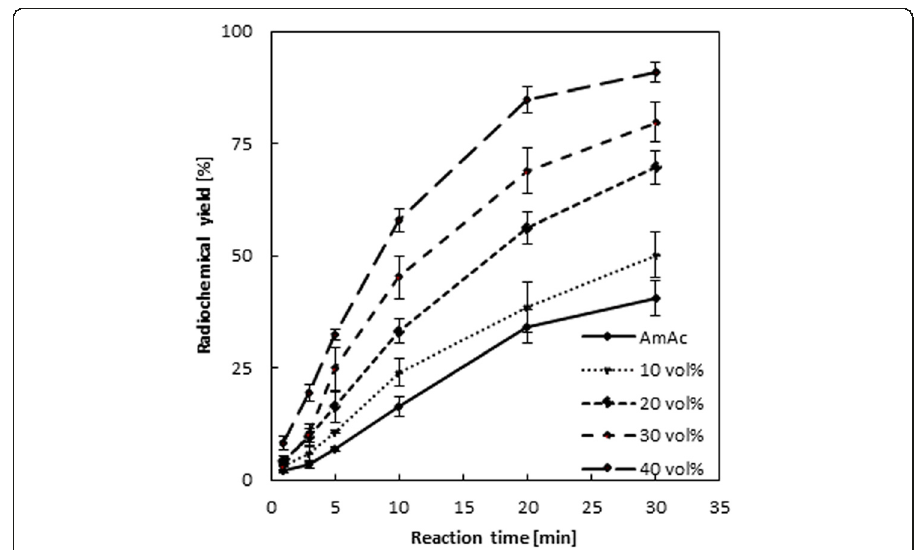
Fig. 6 Labeling kinetics of 44 Sc-DOTATOC in presence of 10 – 40 vol% ethanol compared to the pure aqueous solution containing ammonium acetate (AmAc) as buffer (20 nmol/6.62 μ M/28.5 μ g DOTATOC, 70 °C, n